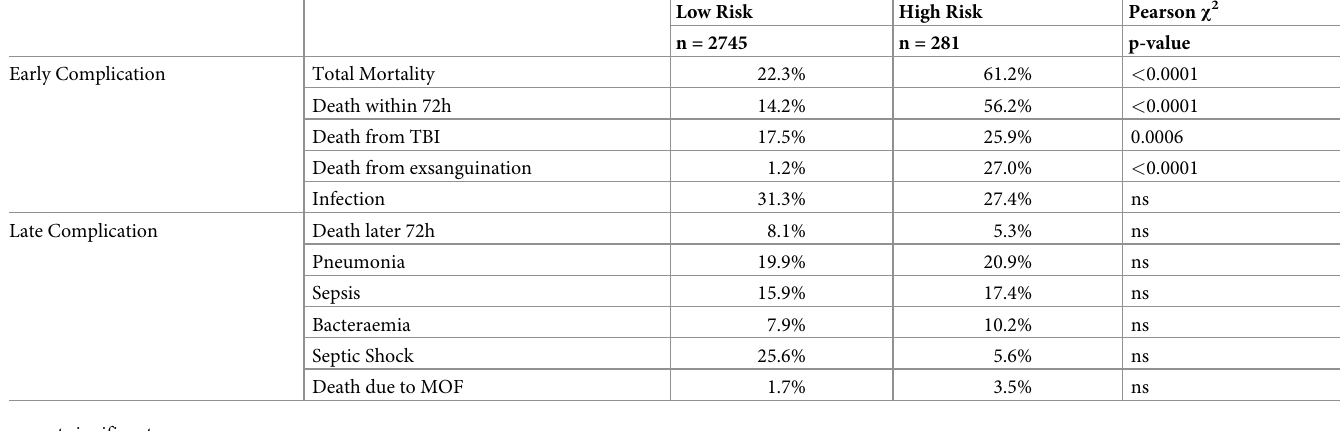
Table 4. Ability to predict early (within 72hours) versus late (after 72hours) complications in patients classified according to